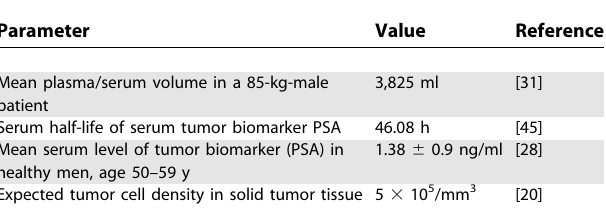
Table 3. General Parameters of the Tumor Biomarker Model PSA Parameter Value